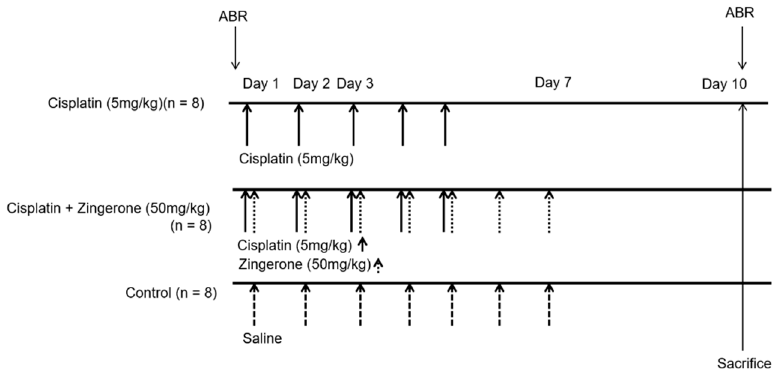
Figure 5. Dosing schedules and measurements used in the present study. Cisplatin (5 mg/kg) was administered to rats in the cisplatin group for 5 days ( n = 10). Cisplatin (5 mg/kg) was administered for 5 days and zingerone (50 mg/kg) was administered for 7 days to rats in the cisplatin + zingerone group ( n = 10). An equal volume of saline was administered to rats in the control group ( n = 10). Auditory brainstem responses (ABRs) were measured on days 0 and 10.